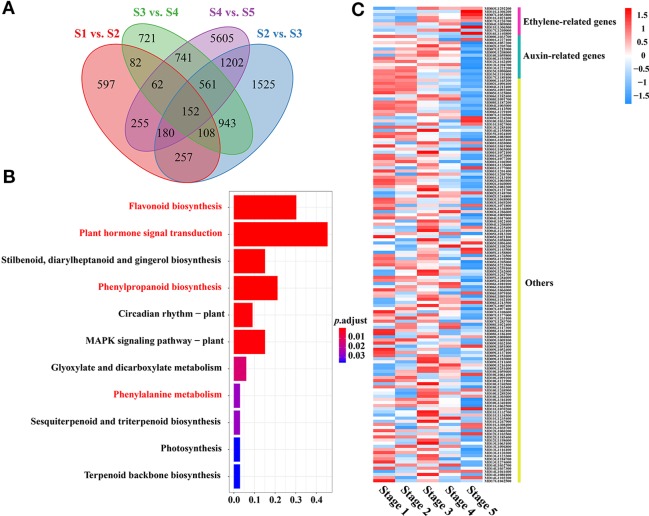
Functional analysis of DEGs between consecutive developmental stages. (A) Venn diagrams for the DEGs between each combination (Stage 1 vs. Stage 2, Stage 2 vs. Stage 3, Stage 3 vs. Stage 4, Stage 4 vs. Stage 5). (B) KEGG (Kyoto Encyclopedia of Genes and Genomes) pathway enrichment of DEGs (152) during fruit development. (C) Heat map comparing DEGs (152) during fruit development.